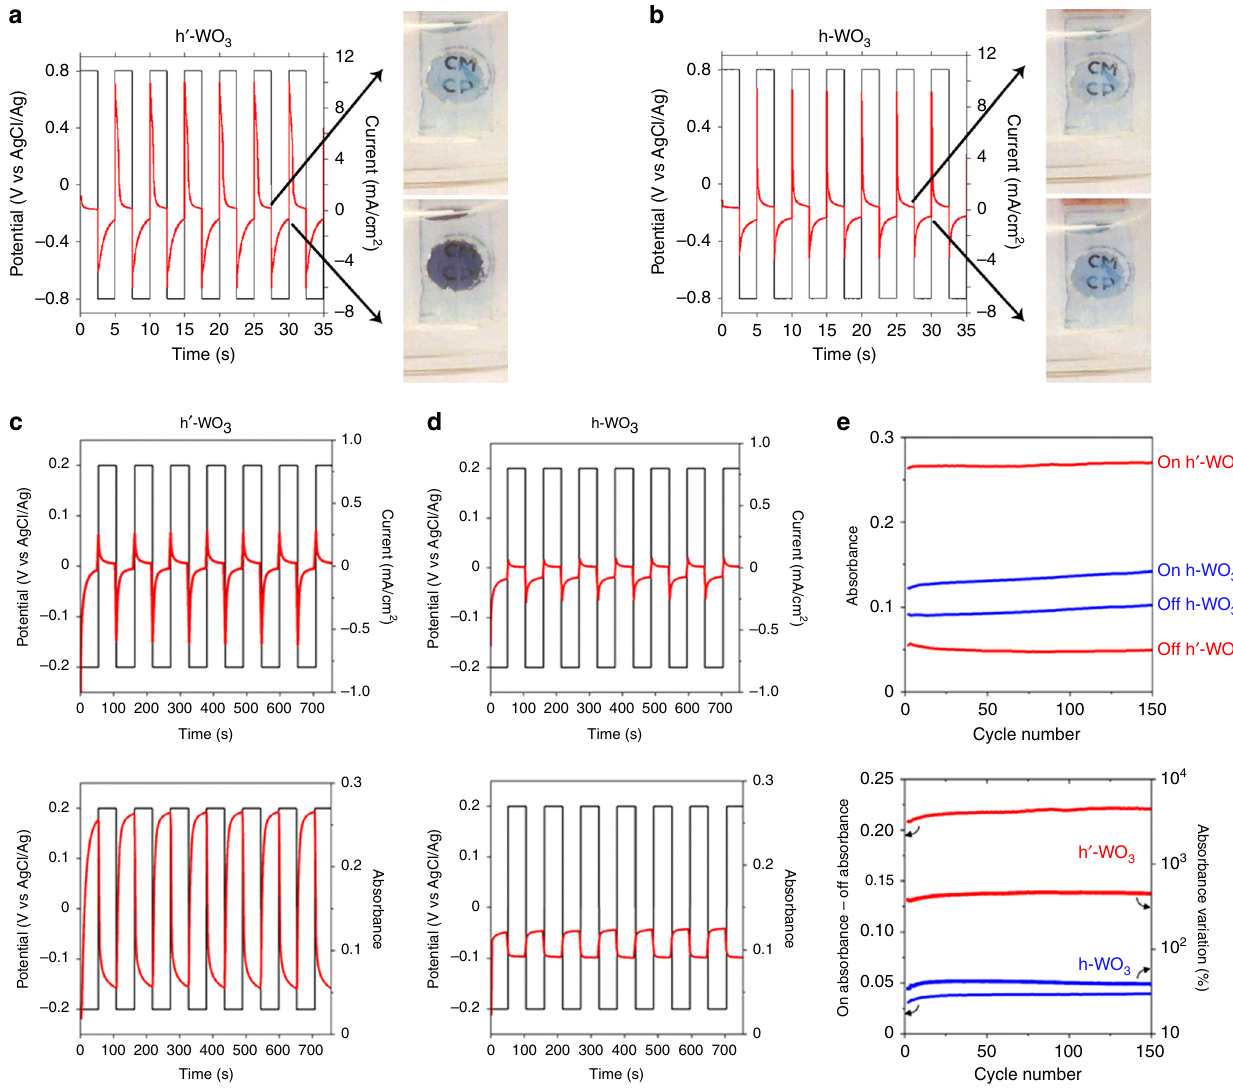
Fig. 5 Electrochromic properties. Current evolution (red curves) upon application of a potential square function (black curves) at ±0.8 V vs. AgCl/Ag and 0.2 Hz for a h ’ -WO 3 and b classical h-WO 3 fi lms spin coated on FTO substrates with H 2 SO 4 0.1 mol L − 1 . Combined electrical and spectroscopic measurements of the electrochromic properties of h ’ -WO 3 ( c ) and classical h-WO 3 ( d ). Evolution of the current (top, red curves) and the corresponding in situ measured absorbance at 700 nm (bottom, red curves) during cycling between − 0.2 and 0.2 V vs. AgCl/Ag at 0.009 Hz. e Variation of the absorbance upon cycling in the oxidized “ off ” (positive bias) and reduced “ on ” (negative bias) states for h ’ -WO 3 and h-WO